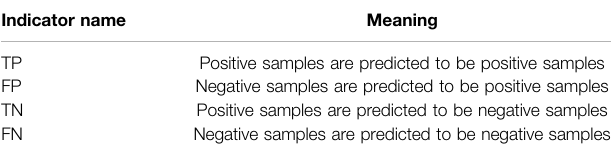
TABLE 6 | Names and meanings of evaluation indexes of the